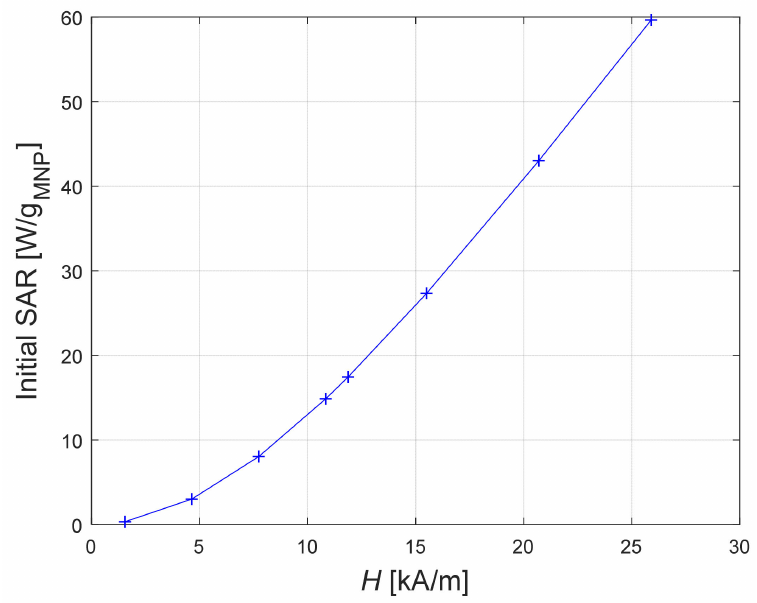
Figure 20. Initial SAR dependence on magnetic field strength amplitude at frequency being f = 281 kHz.